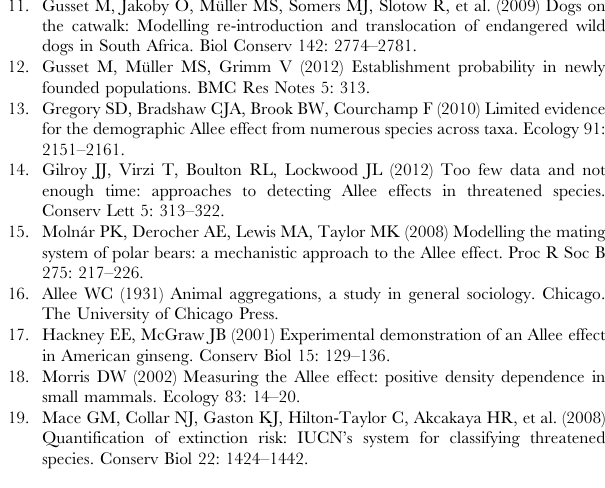
depends on the length of the considered projection (contrast black lines between the two panels), and that (v) the contour line corresponding to no change in population size ( (cid:2) ll ~ 1 ) approxi- mates but does not exactly correspond to the Allee threshold shown in Fig. 2 due to the effects of initial (and potentially long, cf. Fig. 4I–L) transient dynamics. Figure S2 The dependence of the Allee threshold on the mating model parameters s and m 2 1 . For both pair formation rate ( s ) and pair association length ( m 2 1 ), we contrasted outcomes obtained with the baseline parameter values s = 49.2 km 2 d 2 1 and m 2 1 =17.5 d against outcomes obtained with parameter values corresponding to more ( s increased by 50% or m 2 1 decreased by 7 days) and less ( s decreased by 50% or m 2 1 increased by 7 days) efficient mating, respectively. In both panels, scenarios marked red lead to extirpation for all considered parameter values; scenarios marked orange lead to extirpation with the baseline parameter values and the values corresponding to inefficient mating, but not with efficient mating; blue marks scenarios that lead to extirpation with inefficient mating only. The three scenarios largely overlap in panel (B), illustrating the insensitivity of the Allee thresholds to the pair association length m 2 1 . Both panels consider the ‘‘old’’ population scenario, where all females and males are sexually mature adults (i.e., in stages 4 and 10, cf. Fig. 1) at the beginning of the projection, and no female is accompanied by dependent